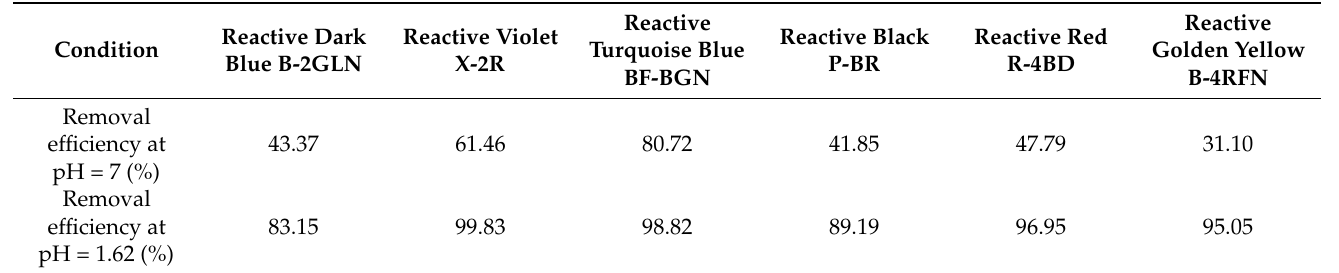
Table 3. Removal efficiency of various dyes over carbon-supported metal nickel at pH = 7 and pH = 1.62.